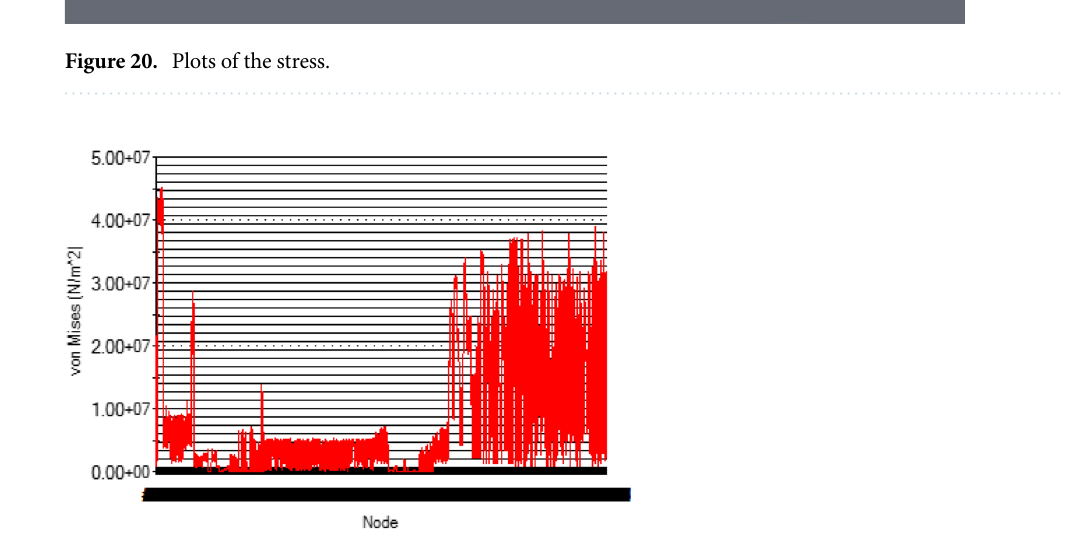
Figure 21. Simulation graph for